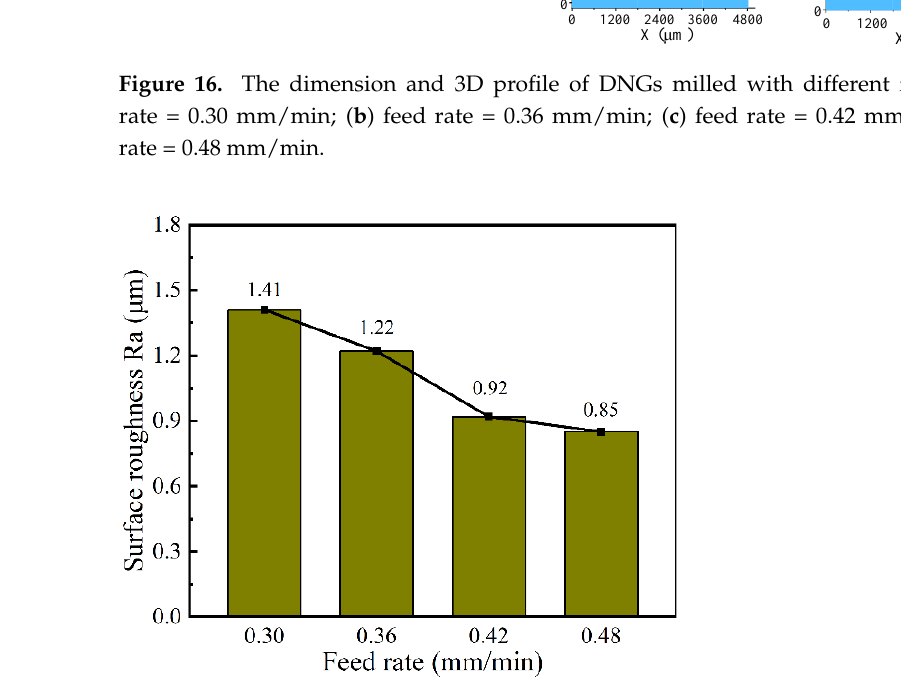
Figure 16. The dimension and 3D profile of DNGs milled with different feed rates: ( a ) feed rate = 0.30 mm/min; ( b ) feed rate = 0.36 mm/min; ( c ) feed rate = 0.42 mm/min; and ( d ) feed rate = 0.48 mm/min.